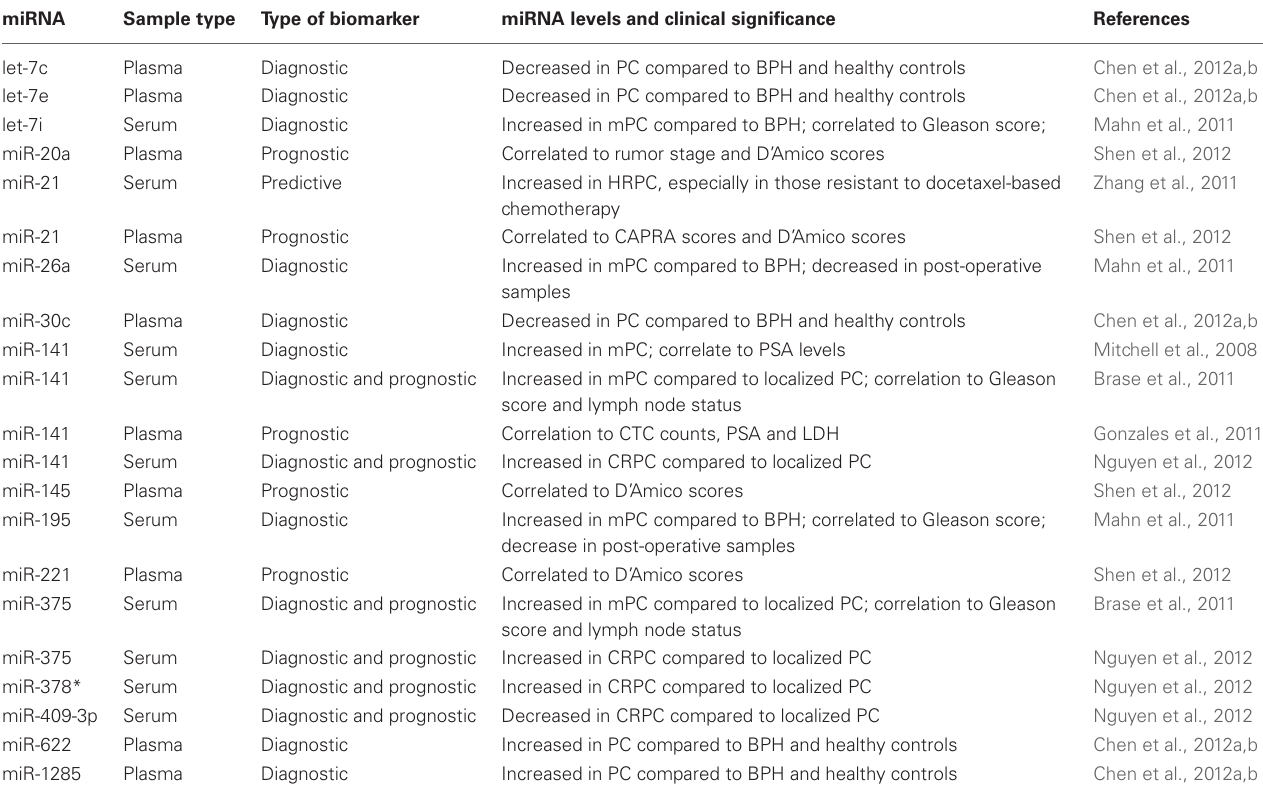
Table 1 | Circulating miRNAs reprted to be a biomarker for prostate cancer.